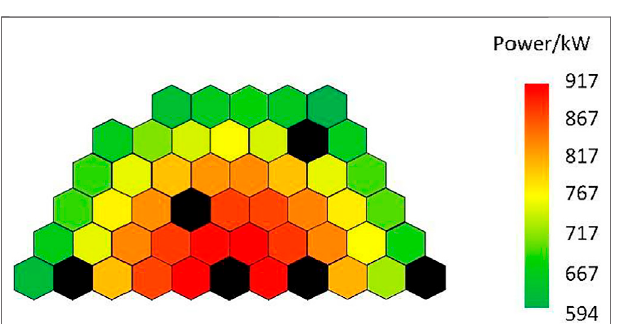
FIGURE 3 | Power distribution of CEFR half core power.